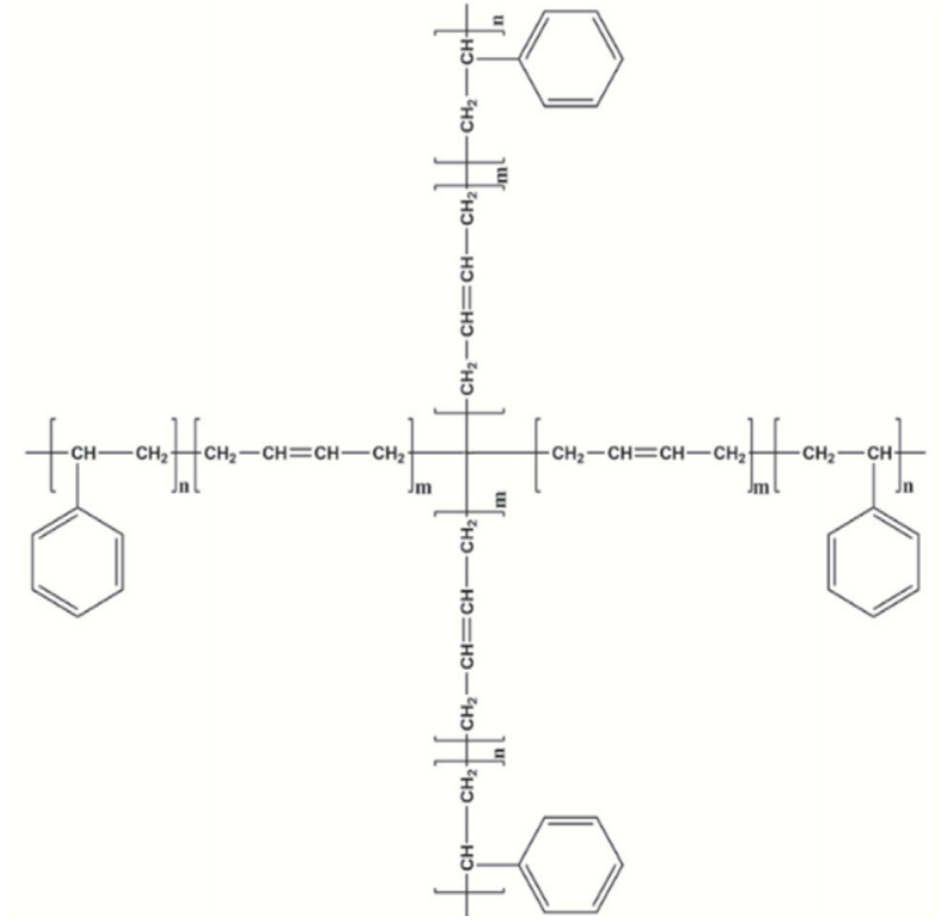
Figure 4. Structural formula SBS-R (radial triblock). Reprinted from ref. [37]. The differences in the composition of polymers can be assessed on the spectrometer basic tests FT-IR and NMR [37]. In the FT-IR, they can be observed mainly in terms of band 750–1200 cm − 1 . The increase in vinyl content significantly increases the intensity of the bands at 910 and 966 cm − 1 due to =C–H vibrations in the polybutadiene (PB) segment [38,39]. The increased vinyl content can facilitate increased interaction between the polymer and the binder molecules due to the decreased steric hindrance to the C=C bond [37–41]. The assignment of the basic bands in the FT-IR spectrum is presented in Table 2. Assignment of the main bands in FT-IR spectra of the SBS polymers Adapted from ref. [37]. Wavenumber (cm − 1 )